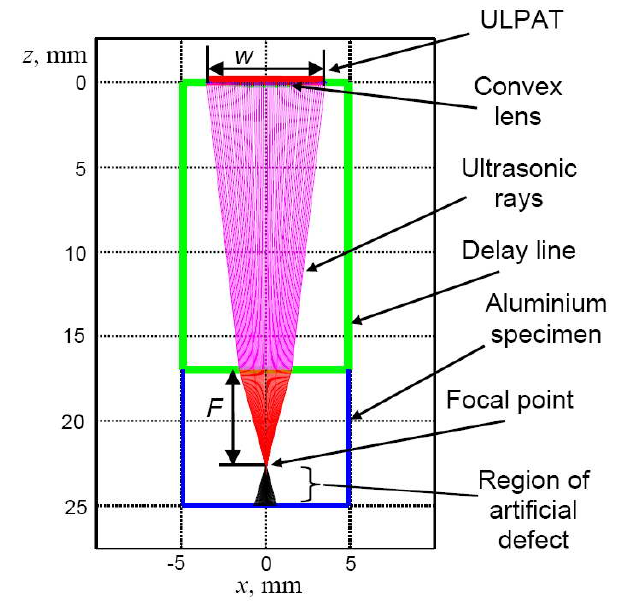
Figure 3. The setup of the investigated aluminium sample possessing artificial crescent-shaped defect (all dimensions are provided in mm, view from the bottom side).